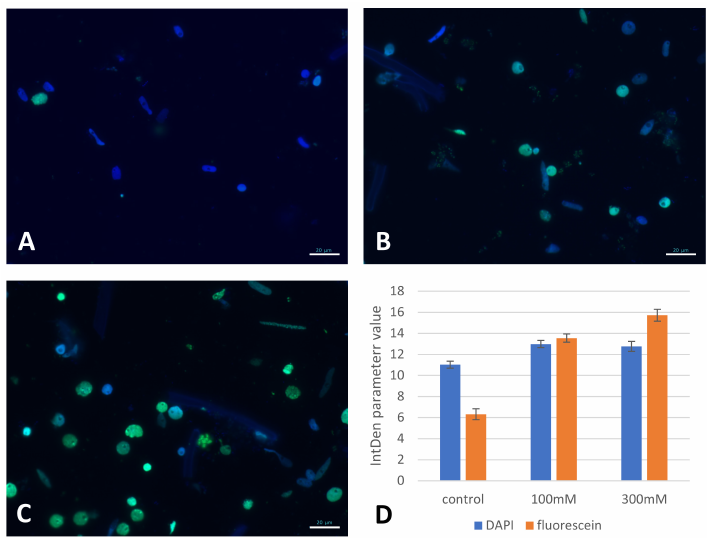
Figure 9. TUNEL test in the root cells of the “salt-shocked” Brachypodium seedlings. ( A ) Control, ( B ) 100 mM NaCl, ( C ) 300 mM NaCl. DAPI stained nuclei with or without green fluorescence of built-in fluorescein as a result of the TUNEL reaction. Levels of relative fluorescence intensity (IntDen parameter) of DAPI and fluorescein ( D ); values are shown as the average values ± SE. Blue colour—DAPI fluorescence; green colour—fluorescein fluorescence. Scale bars represent 20 µm.